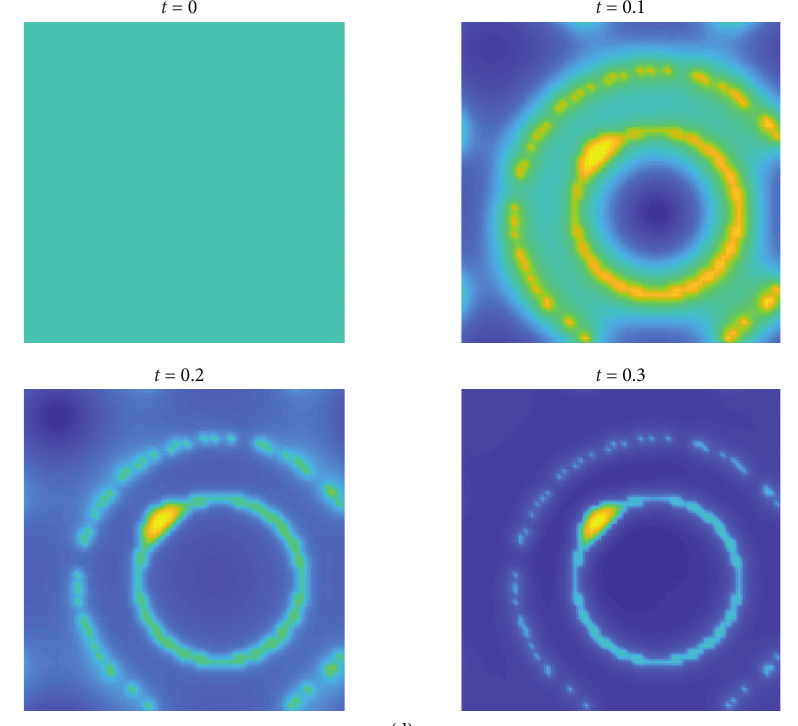
Figure 11: Numerical solution and Turing pattern of Experiment 2 with initial condition u ( x,y, 0 ) � cos (− π (( x − 0 . 4 ) 2 + ( y + 0 . 4 ) 2 )) − e − 20 (( x + 0 . 4 ) 2 +( y − 0 . 4 ) 2 ) and v ( x,y, 0 ) �